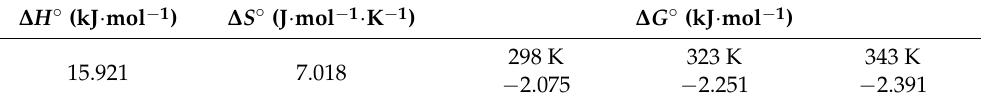
Table 6. FactorscontrollingthethermodynamicsofCo 2+ adsorptionuponPTU-MSAatdifferenttemperatures.